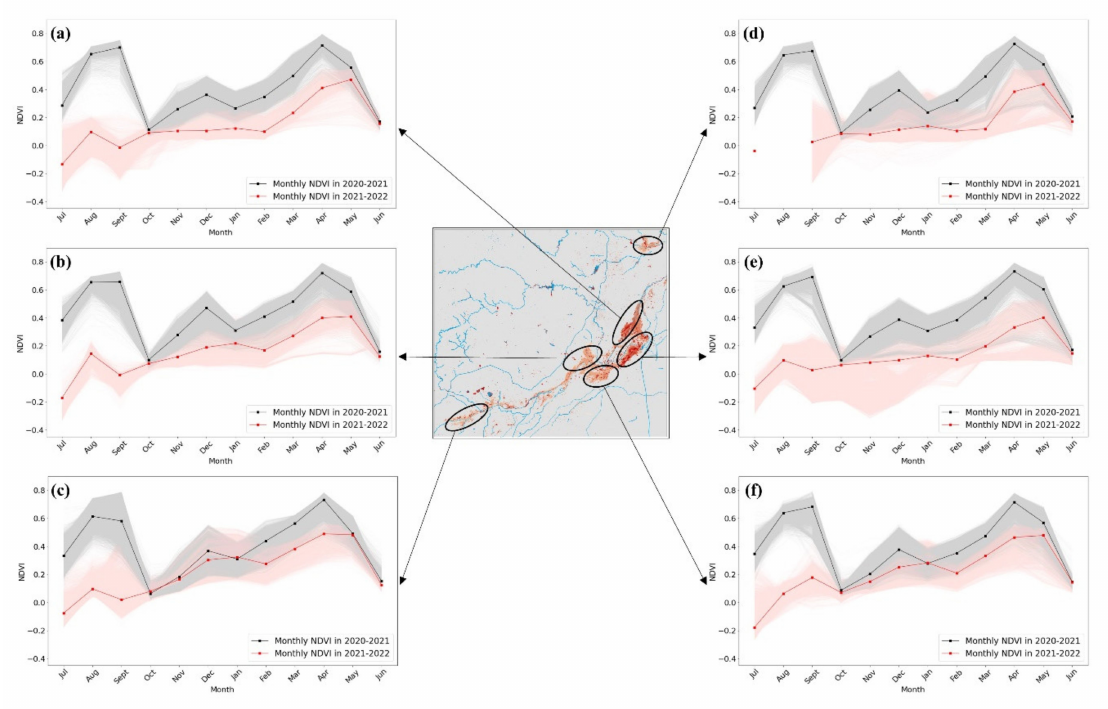
Figure 8. ( a – f ) are the seasonal variation in NDVI per pixel in different regions of the study area. The light gray lines indicate the NDVI value for each pixel within the cropland-covered flooded area in the corresponding hotspot area from July 2020 to June 2021; the black line indicates the averaged NDVI of all pixels within the corresponding region from July 2020 to June 2021; the light pink lines indicate the NDVI for each pixel within the cropland-covered flooded area in the corresponding hotspot area from July 2021 to June 2022; and the red line indicates the averaged NDVI of all pixels within the corresponding region from July 2021 to June 2022. The figure was plotted by Python3.9